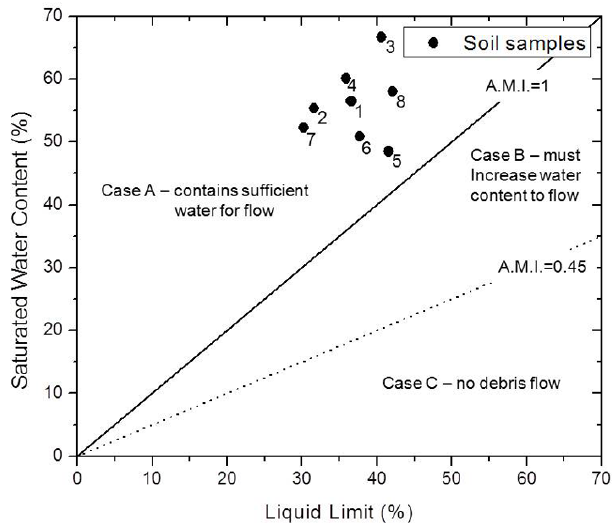
Fig. 13. Relationship between saturated water content and liquid limit of soil samples. Numbers identify samples in Table 3: (a) per- centage of predicted FS and landslide and (b) percentage of LR class